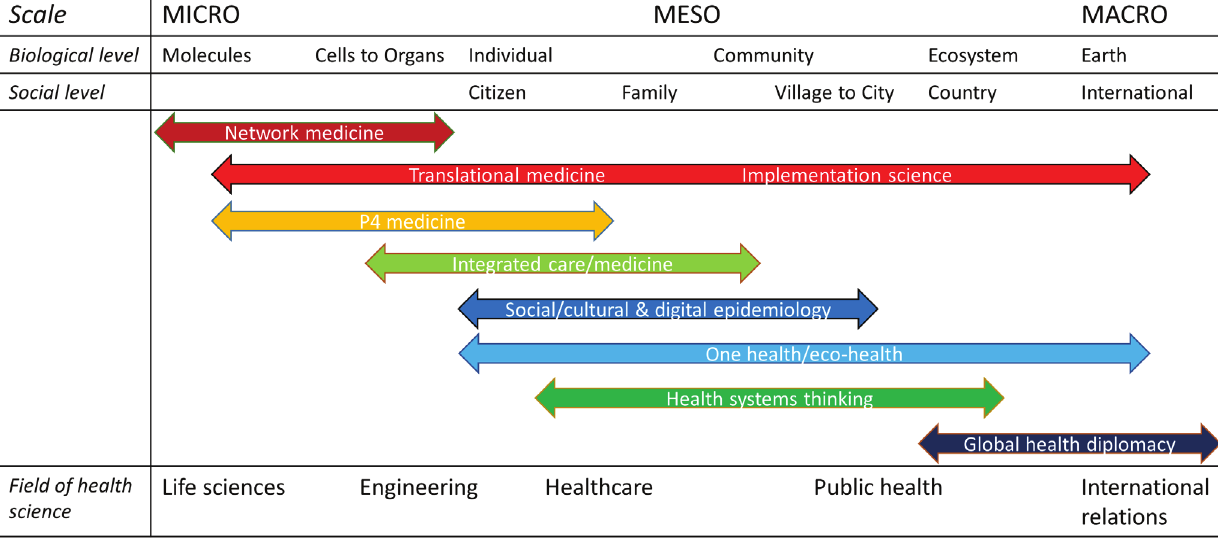
Figure 1. Scope of selected interdisciplinary research and education approaches in academic global